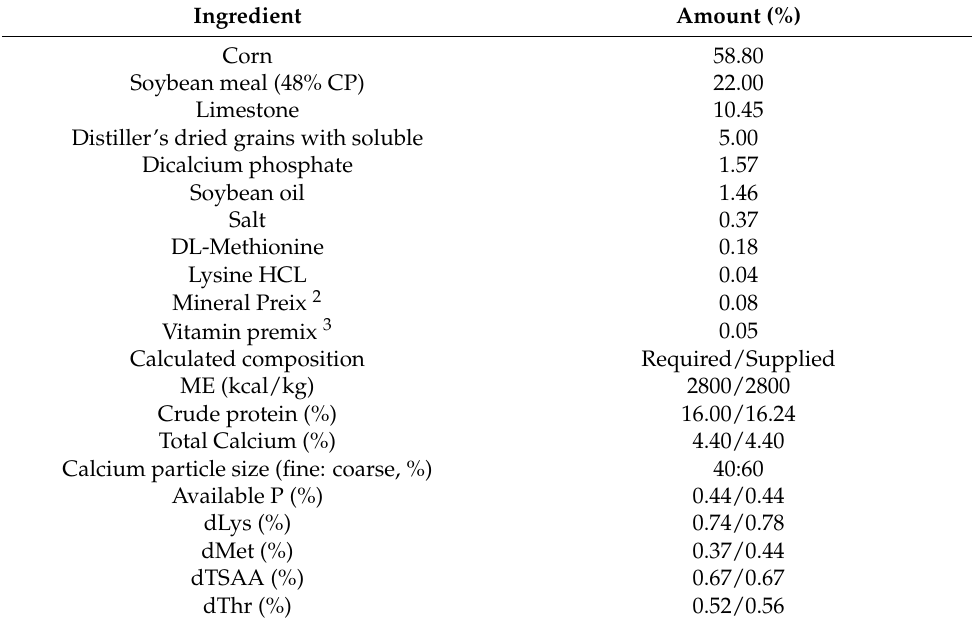
Table 1. Ingredients and nutrient composition of Hy-Line W-36 laying hen 1 control diet (dry matter